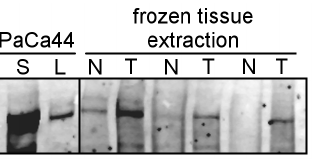
Figure 10. Western blot analysis of exemplary pancreatic cancer and normal tissue pairs confirms Fat1 protein-overex- pression. Western blot analysis of Fat1 in extracts from three matched pairs of pancreatic cancer tissues and corresponding normal adjacent pancreas. Extracts were prepared from frozen fresh tissues (75 m g protein analysed); cell lysate (L, 75 m g) and secretome (S, 8 m g) fraction from PaCa44 cells are shown for